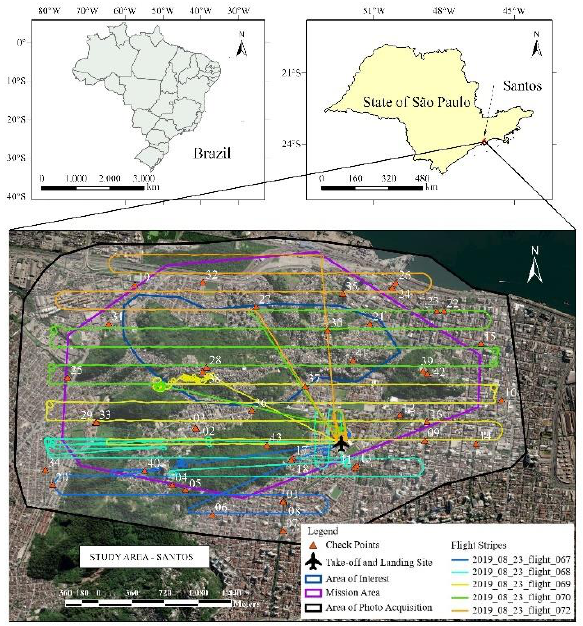
Figure 1. Case Study: City of Santos in State of São Paulo, Brazil.